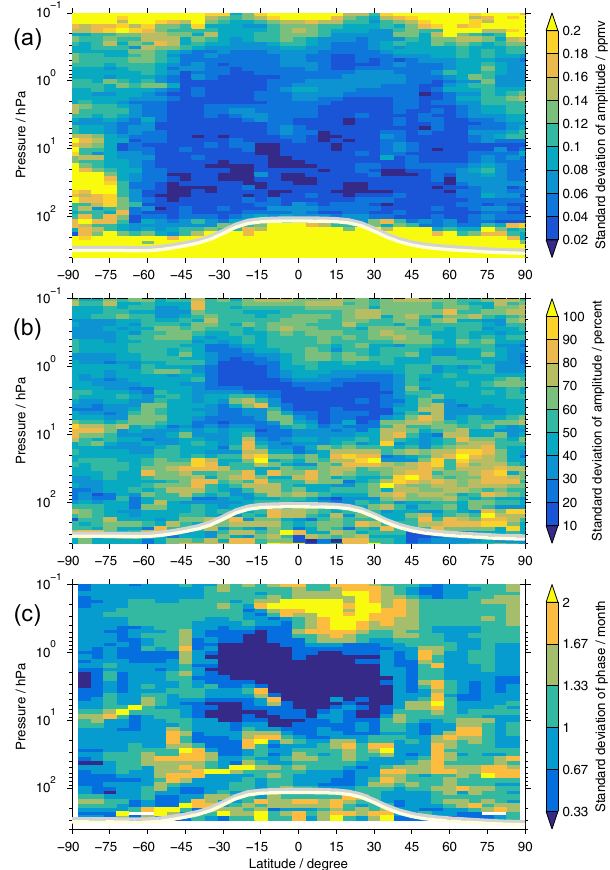
Figure 10. As Fig. 5 but here the semi-annual variation is consid- ered. Note the different scales for the absolute standard deviation in amplitude and phase compared to Fig.